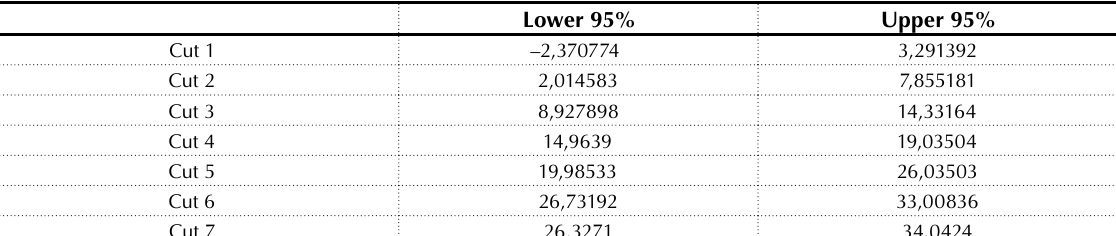
Table A1. Confidence Intervals for